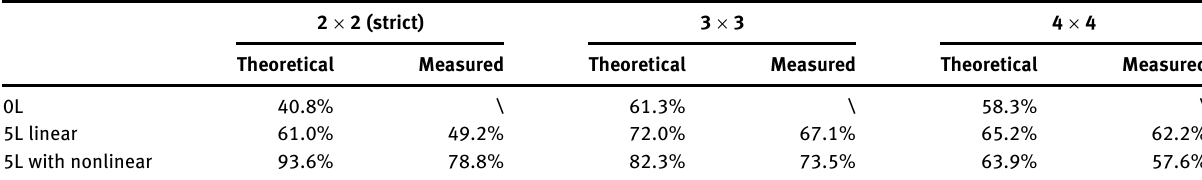
Table  : Comparison of the theoretical calculated and experimental measured test set accuracy of the eigenvalues for different order matrices.  ×  (strict)  ×   ×